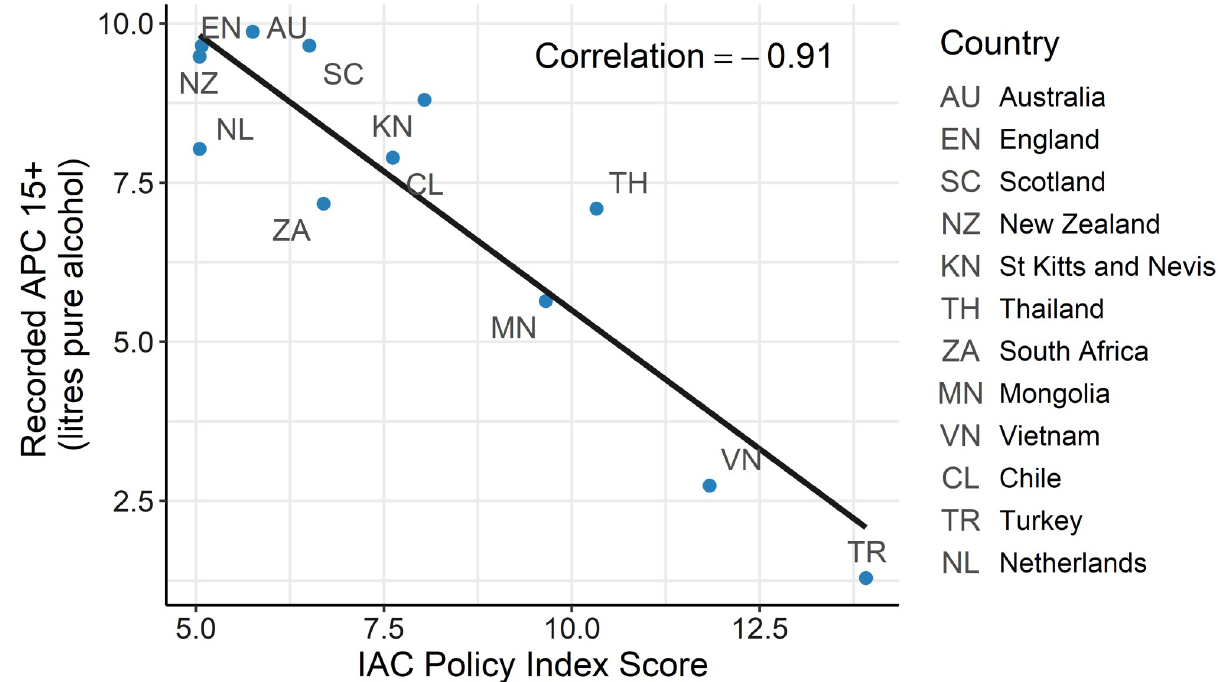
Fig 1. Relationship of policy index with recorded APC.